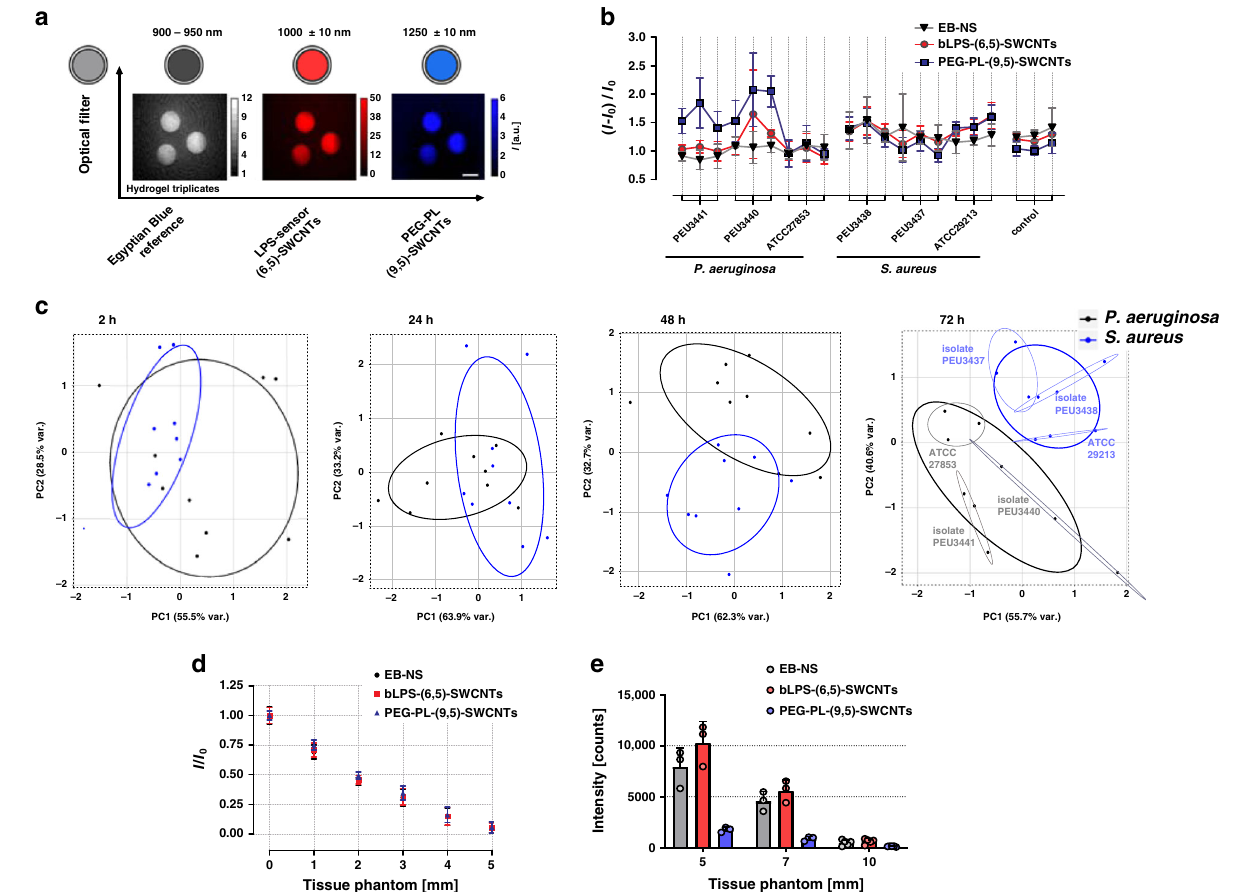
Fig. 5 Hyperspectral remote detection of bacteria. a Multi-color sensor HGs are created by incorporating EB-NS as reference NIR- fl uorophore and two chirality-puri fi ed SWCNT sensors (LPS-binding-peptide-(GT) 20 @(6,5)-SWCNTs and PEG(5 kDa)-PL@(9,5)-SWCNTS), which enables spectral multiplexing. NIR fl uorescence images were captured with optical fi lters, resulting in three emission/color channels (EB-NS 900 – 950 nm, bLPS 1000 nm and PEG 1250 nm). Note that heterogeneity in fl uorescence of the three technical replicates is caused by inhomogeneous illumination intensity and not relevant for quanti fi cation because of normalization to the EB-NS reference (scale bar 0.5 cm). b Fluorescence change of the hyperspectral sensors after 72 h of incubation with P. aeruginosa and S. aureus show distinct responses for one reference strain and two clinical isolates (n = 3 independent experiments, mean ± SD). c PCA of the spectrally encoded sensors for different timepoints. Each point represents one biological replicate of the indicated strain. Ellipses indicate the 0.68 bivariate con fi dence interval. d Tissue penetration through chicken phantom (561 nm excitation, 130 mW, 6 s integration time, n = 3 sensor spots, mean ± SD). Intensity decreases with tissue thickness. e If the integration time is increased (25 s, 190 mW excitation power) spectrally encoded bacterial sensors can be read out through 7 mm of tissue phantom ( n = 3 independent experiments, mean ±